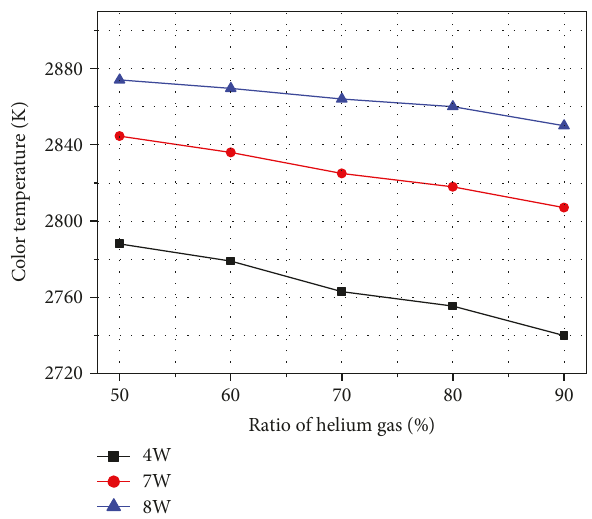
Figure 5: Color temperature changed in the A60 LED fi lament lamps of di ff erent helium in fl ating